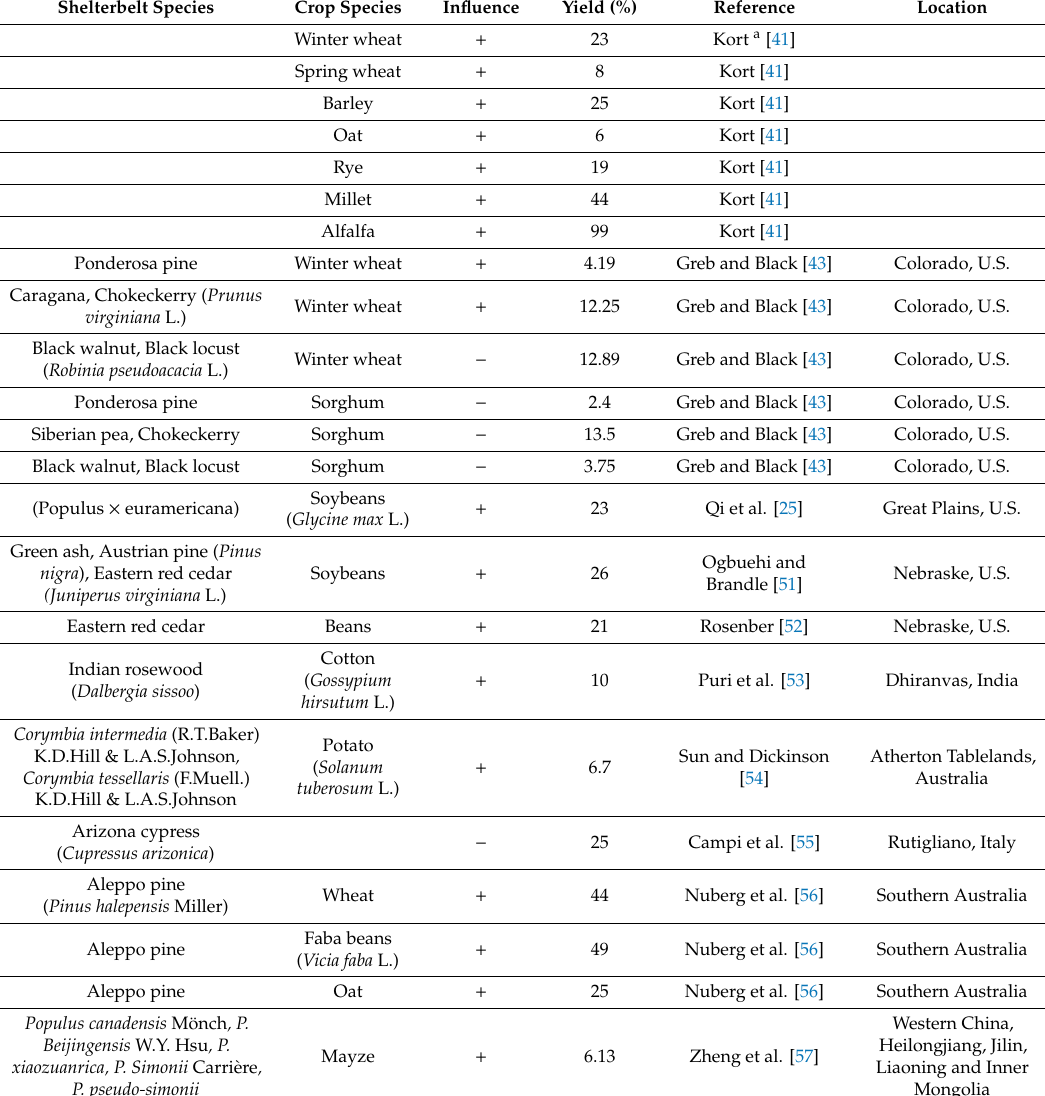
Table 1. E ff ect of shelterbelts on adjacent crop yield from studies around the